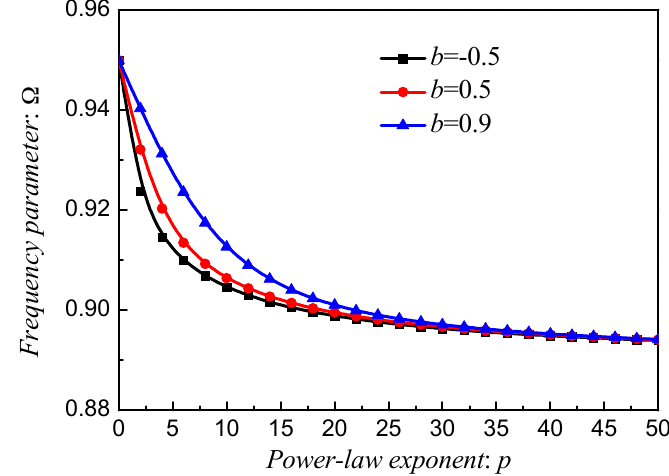
Figure 11. Results about different p and b of stepped FGM I ( a = 1; b , c = 2; p ) paraboloidal shell.